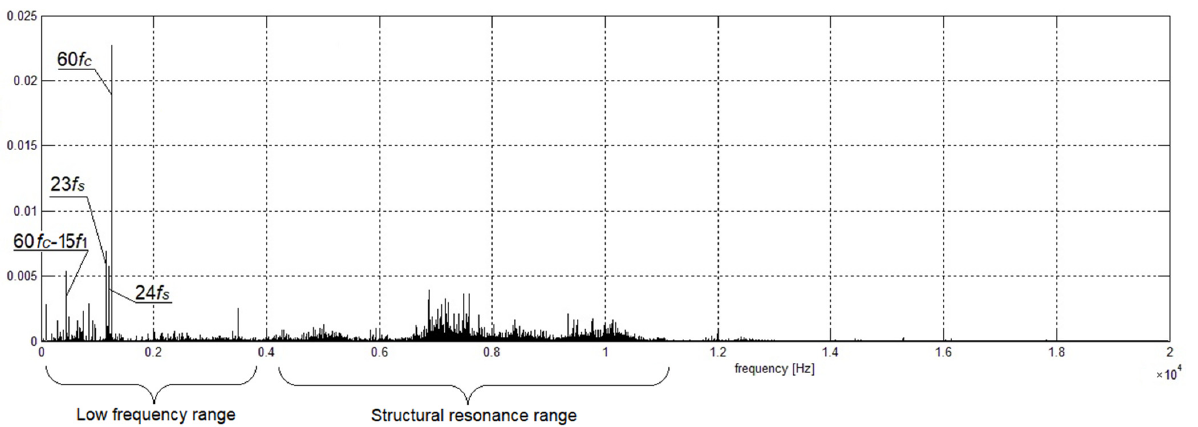
Figure 5. Enlarged central part of F-F image of the frequency spectrum of a healthy motor’s outer casing vibration acceleration ( f P = 2 f s ), with marked reference pattern horizontal and vertical coor- dinates.